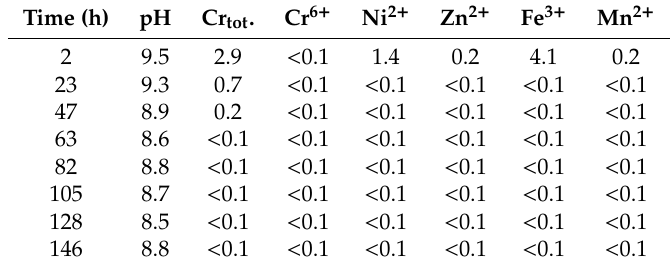
Table 4. Residual concentration of Cr tot. , Cr 6 + , Ni 2 + , Zn 2 + , Fe 3 + , and Mn 2 + in water leaving the filter-press (mg /